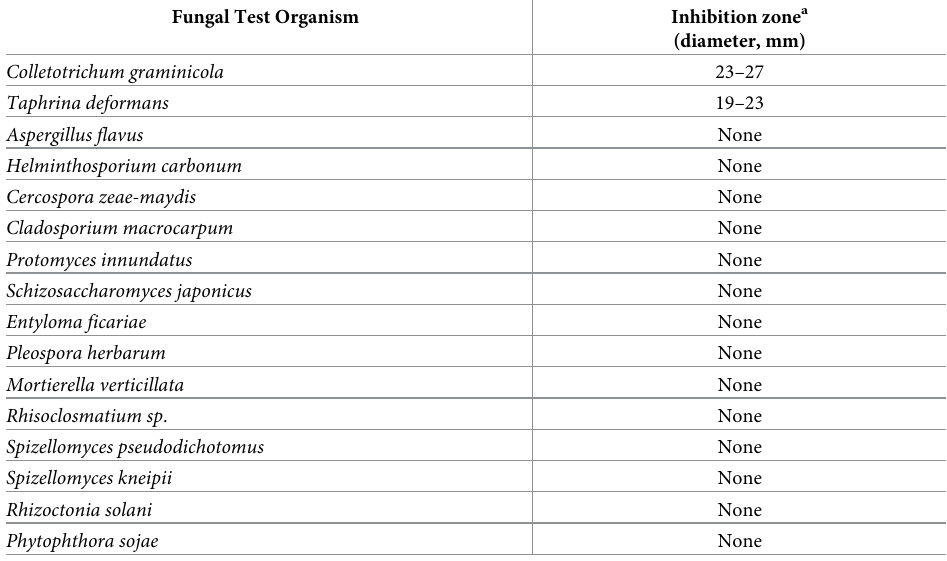
Table 1. Inhibition of different fungal plant pathogens (10 4 cfu ml -1 ) by kochia seed